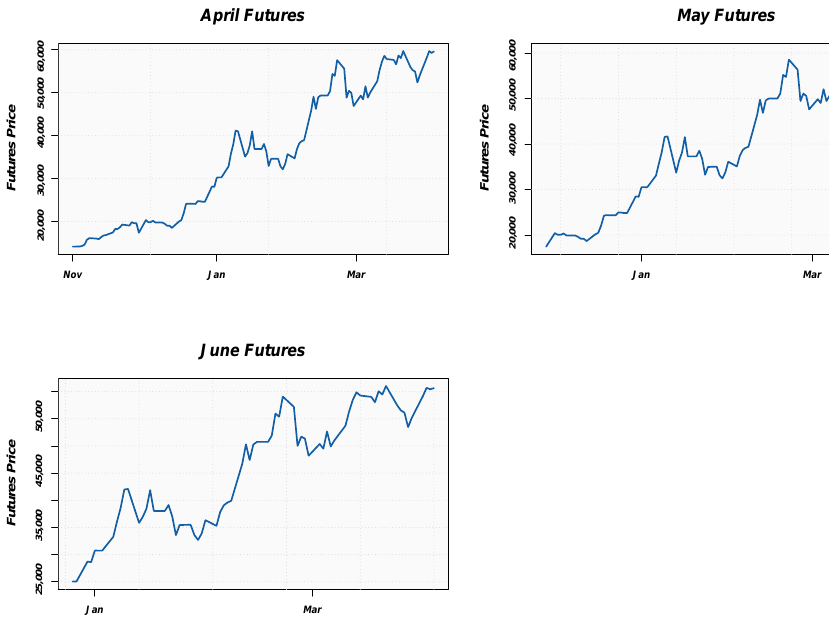
Figure 1. Bitcoin futures.